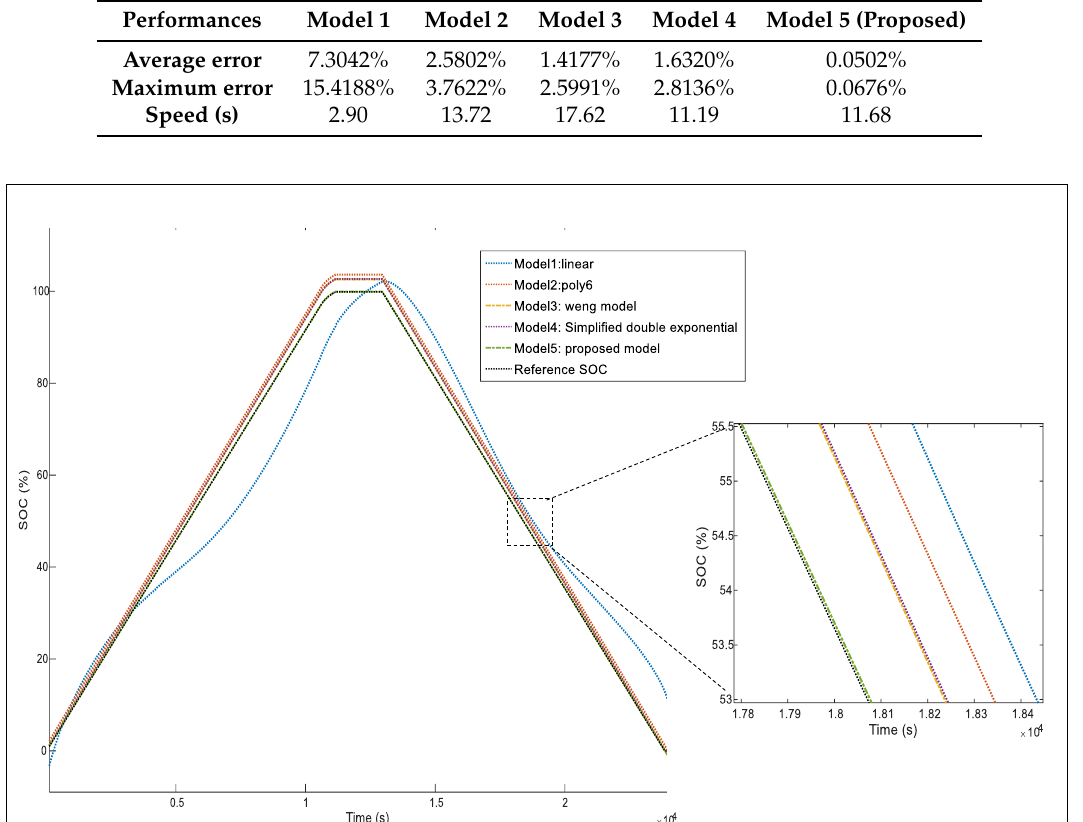
Figure 15. EKF simulation using different OCV models (constant current load) at 25 ◦ C.